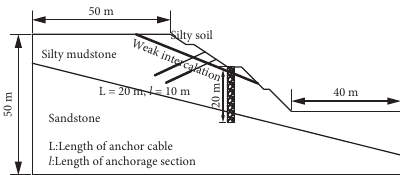
Figure 3: Section size of finite element model.